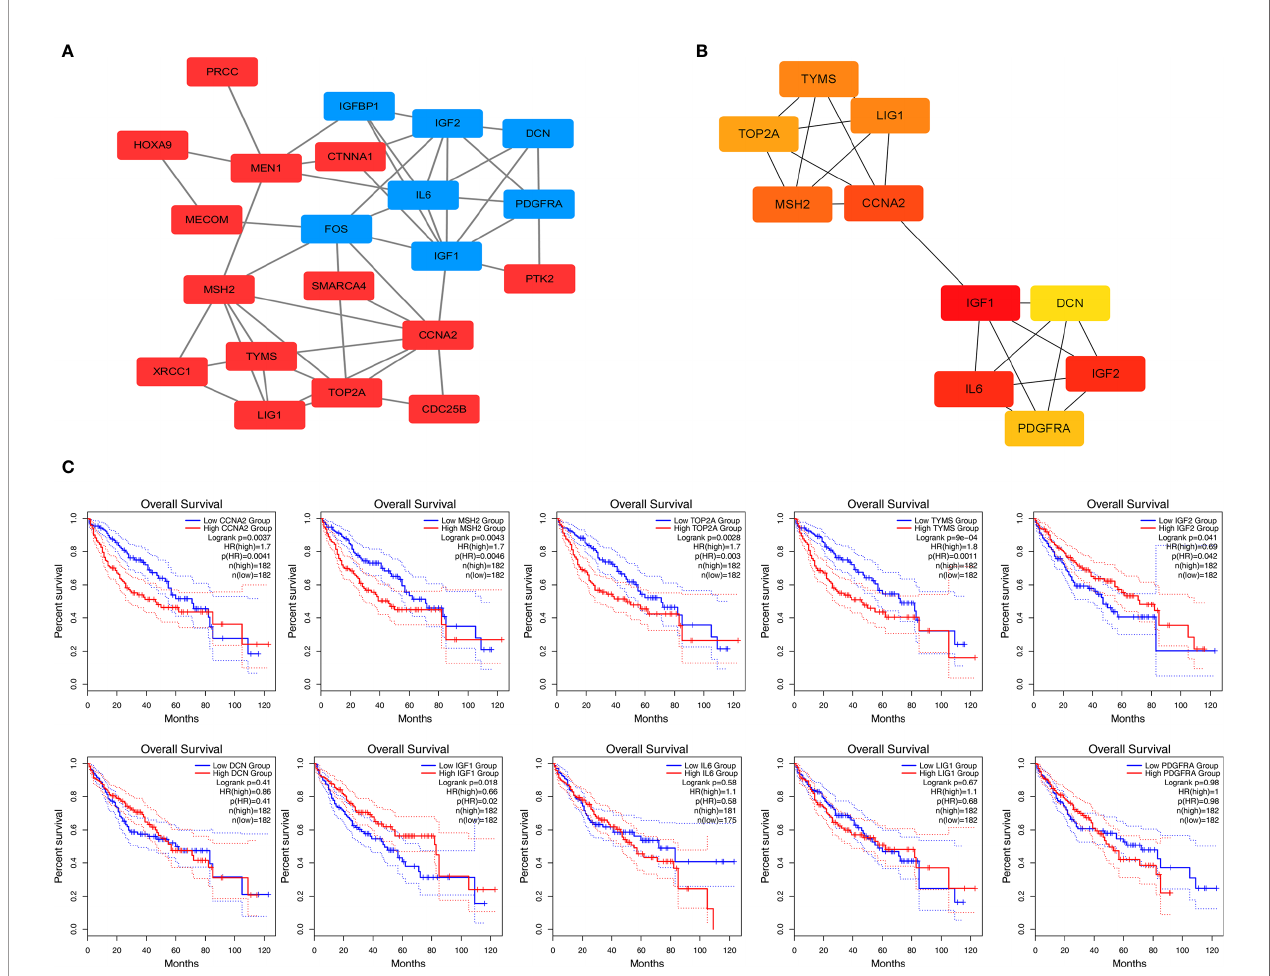
FIGURE 3 | Protein-protein interaction network and overall survival analysis of DEGs. (A) Based on the STRING online database, a PPI network was constructed containing 23 DEGs (upregulated DEGs labeled in red and downregulated DEGs labeled in blue). (B) Identi fi cation of hub genes MCC algorithm. (C) Survival analysis for TYMS in HCC from the GEPIA2